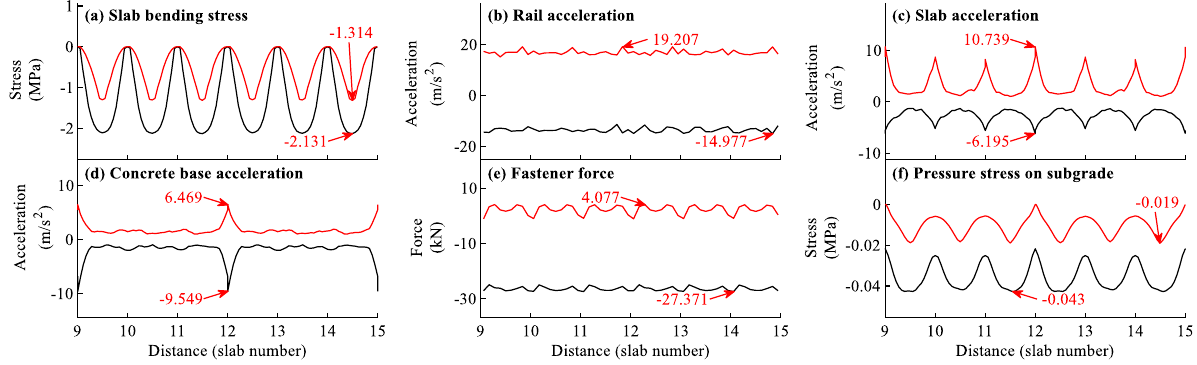
Figure 7. Envelope curves of the dynamic responses for load case when f = -45 °C/m.